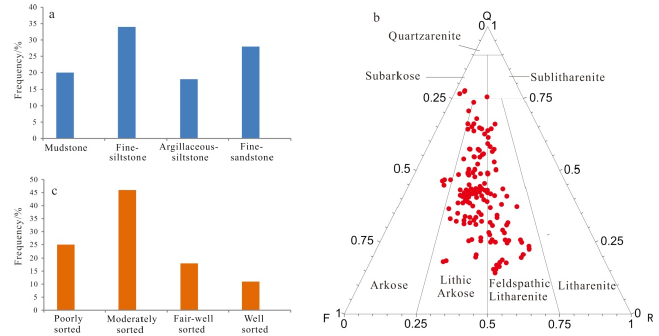
Figure 4. Rock composition lithology and sorting distribution of the Lulehe Formation sandstone reservoirs: ( a ) Lithology distribution; ( b ) Ternary diagram illustrating the classification of sandstone on base of Folk’s [36] classification; ( c ) Sorting